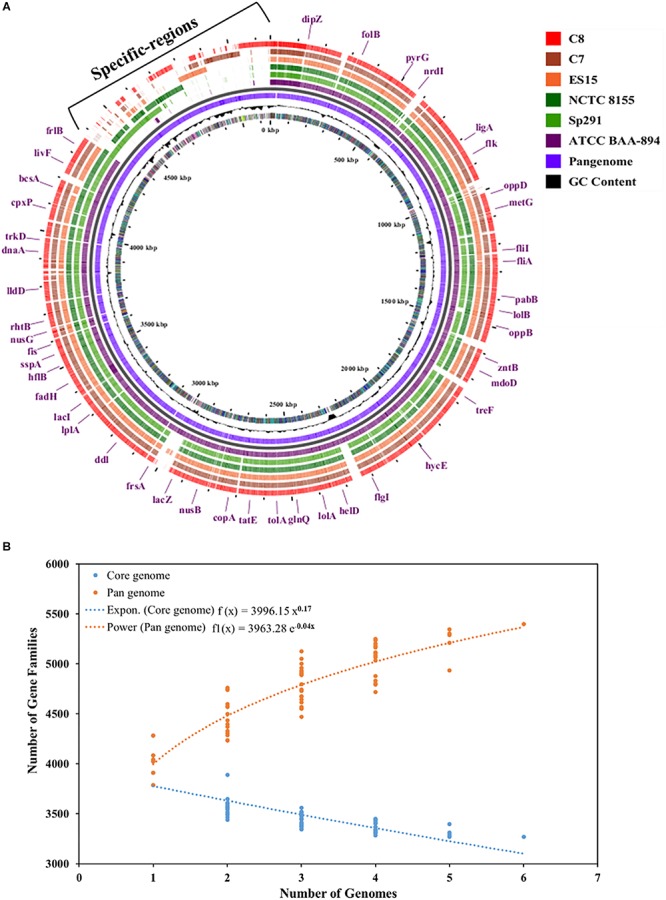
(A) Pan-genome of six C. sakazakii strains (4 database genomes and the 2 isolates) was visualized using the Gview server (Zheng and Huang, 2004; Petkau et al., 2010). The cut-off value was 80% of BlastN homology. The annotation indicates clusters of conserved genes with C. sakazakii (ATCC BAA-894). (B) Plot showing the pan- and core-genome of C. sakazakii. The overall number of genes or pan-genome (Orange) and shared or core-genome (Blue) of 6 C. sakazakii are shown in the plot. The pan-genome consists of 5399 genes, while the core-genomes are made up of 3268 genes.